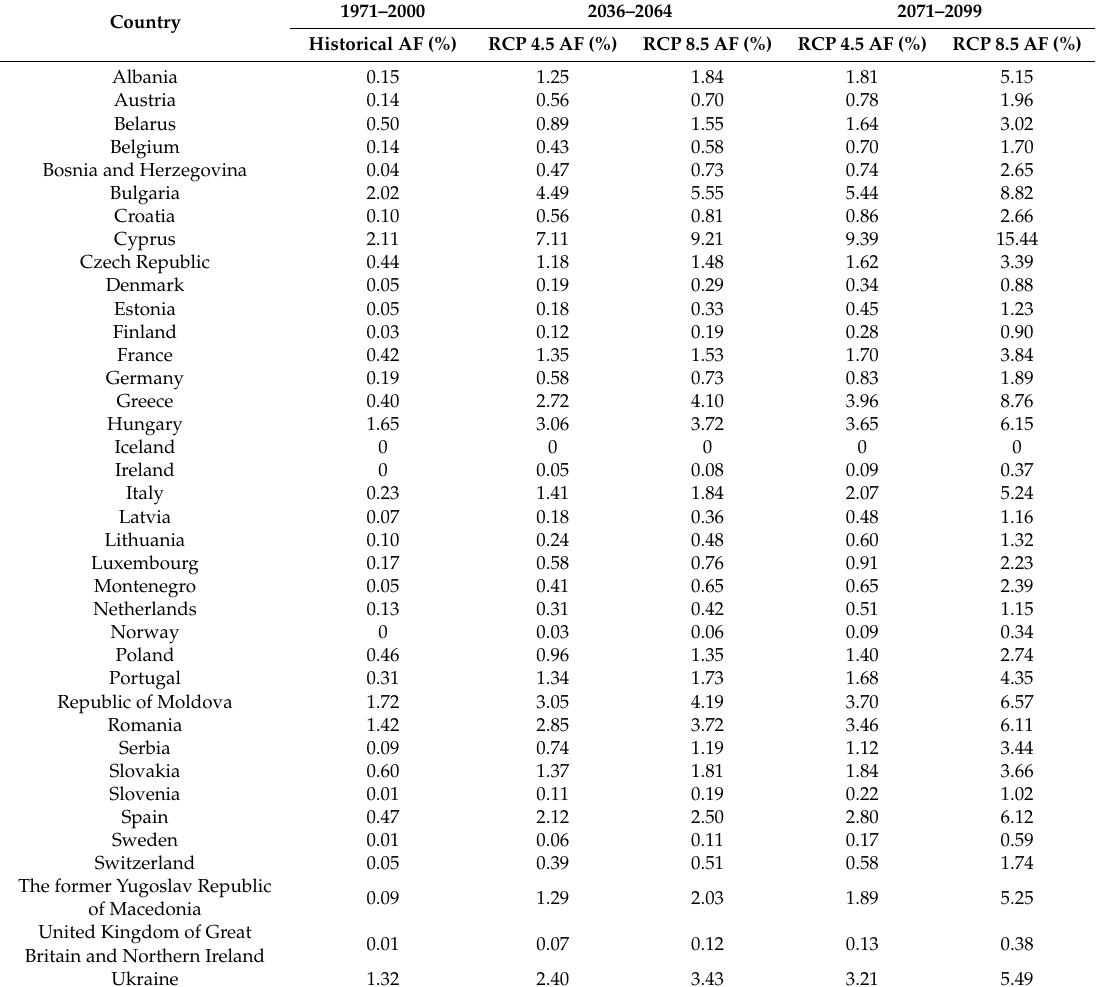
Table 3. Expected fractions of deaths attributable to mean apparent temperatures above the comfort threshold, evaluated over the historical period 1971–2000 and over the future time slices 2036–2064 and 2071–2099 under the RCP 4.5 and RCP 8.5